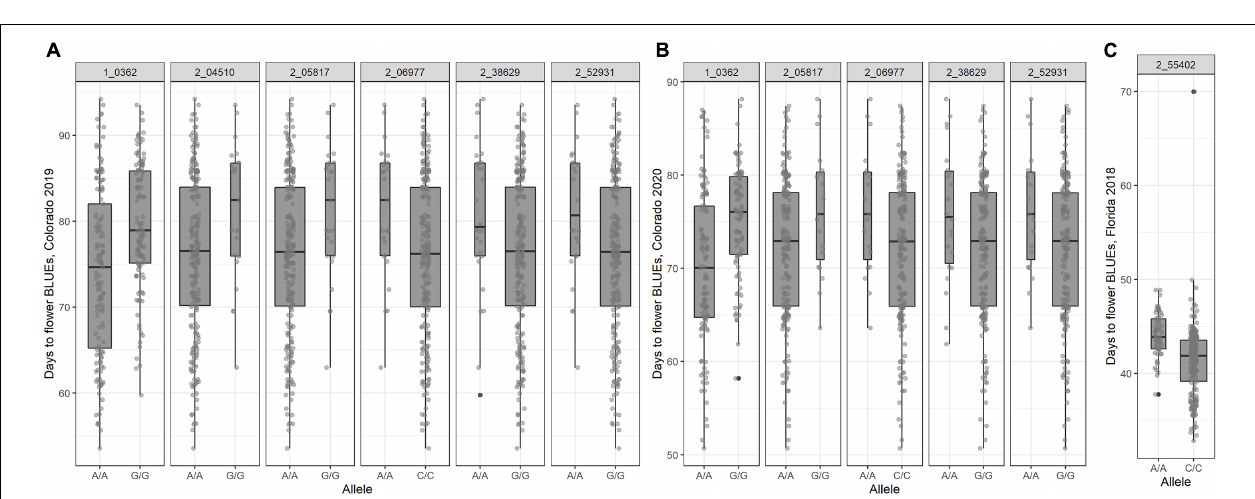
FIGURE 2 | PhenoGram showing significant marker-trait associations for flowering time on each chromosome. The gray bars within each chromosome show the locus of SNPs in the chromosome. Each shape represents a significant SNP identified by the three algorithms (circle = BLINK, diamond = FarmCPU, and triangle = GLM). The color within each shape represents SNPs identified in the different studies (blue = Colorado 2019, green = Colorado 2020, and red = Florida 2018).